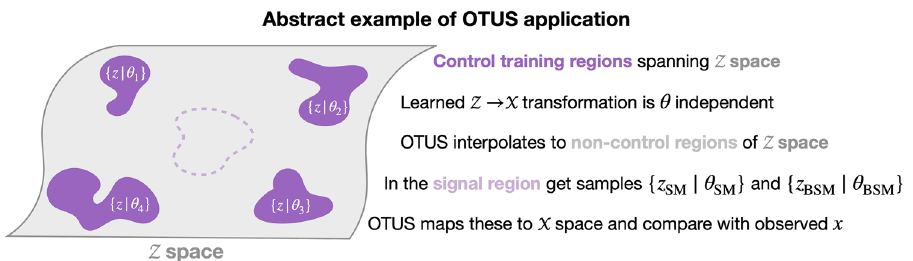
Figure 2. Schematic diagram of how OTUS can be used in an abstract analysis. The gray surface represents Z . Different theoretical models, θ i , will produce different signatures { z i | θ i } which lie in Z . The goal of OTUS is to learn a general mapping from Z → X which is independent of the underlying theory, θ , and only depends on the information contained in { z ∈ Z } . One trains OTUS using control region data which span Z and have known outcomes in X . These allow us to pair distributions in Z with distributions in X . From these examples, OTUS interpolates to the rest of Z and can then be used to generate { x i } from samples { z i | θ i } from regions not used during training, including the blinded signal region. This can then be used to search for new